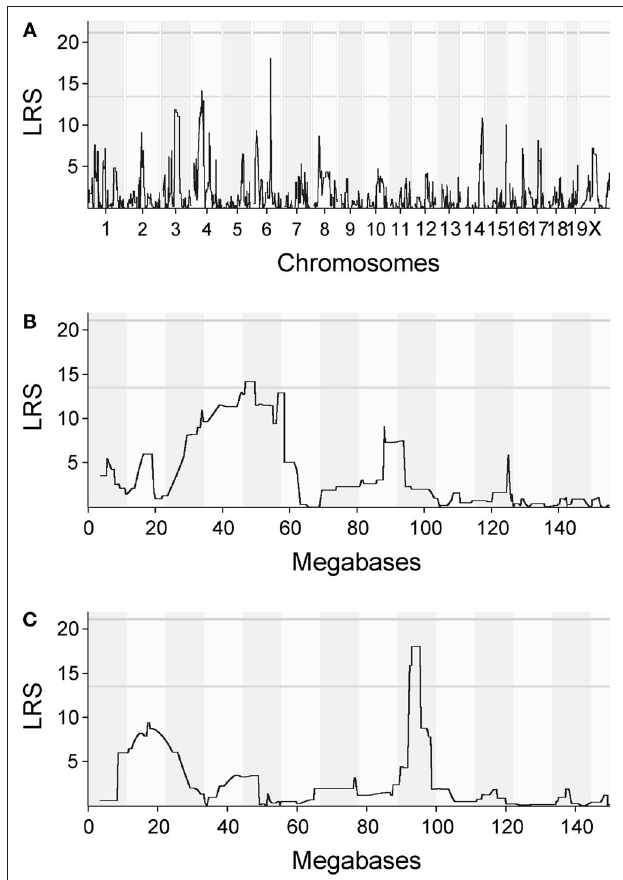
Figure 4 | QTL maps for initial magazine checking behavior. (A) Quantitative trait loci (QTL) map for initial magazine checking behavior. QTL map for initial magazine checking behavior presents likelihood ratio statistics for the trait over the whole genome. Numbers on the x -axis represent chromosomes. Suggestive and conservative significance thresholds are marked by gray horizontal lines. The likelihood ratio statistic (LRS) score reaches the suggestive threshold on chromosomes 4 and 6. (B) QTL map for initial magazine checking behavior, zoomed in on chromosome 4. LRS for the chromosome 4 reaches its peak around 47–48 megabases (MB). The abscissa runs from 0 to 155 megabases. (C) QTL map for the same trait, zoomed in on chromosome 6. LRS reaches the threshold for suggestive QTL around 93–95 MB. The abscissa runs from 0 to 145